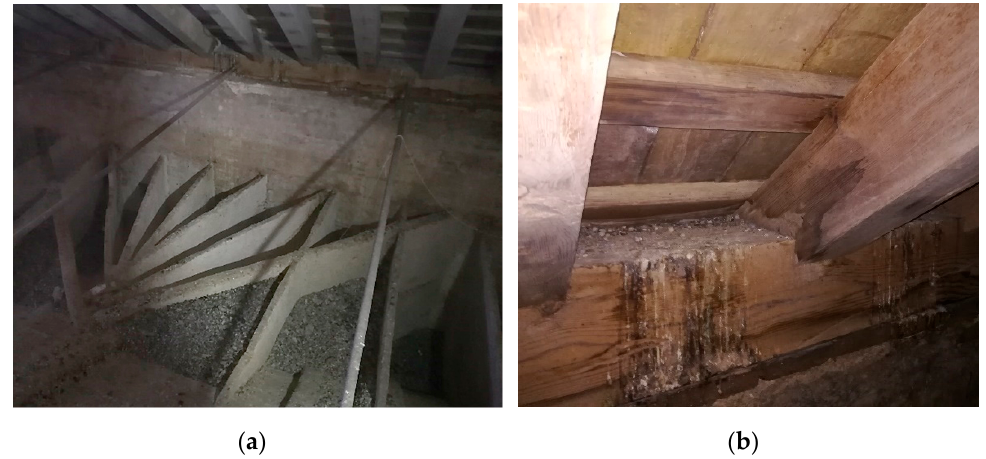
Figure 12. ( a ) Appearance of the structure: dirt and pigeon guano were found in large quantities; ( b ) joint between the rafter and wall plate with pigeon guano, moisture, and colouration changes.